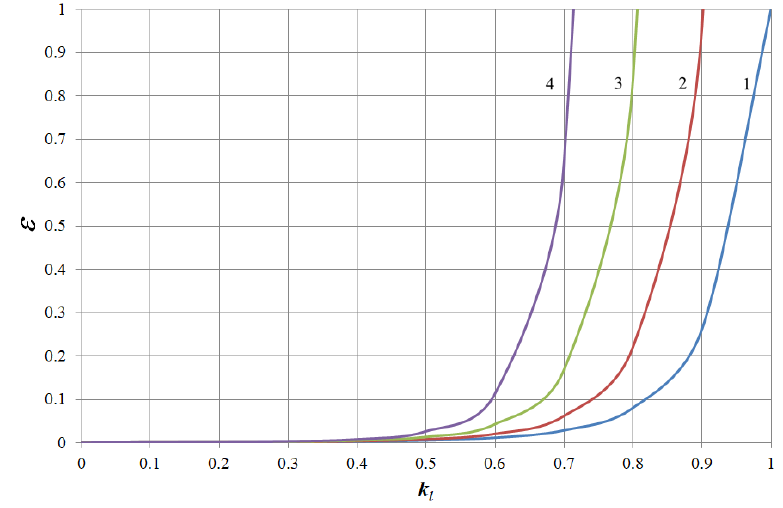
Figure 7. Dependence ε = f ( k l ) at х = 2.